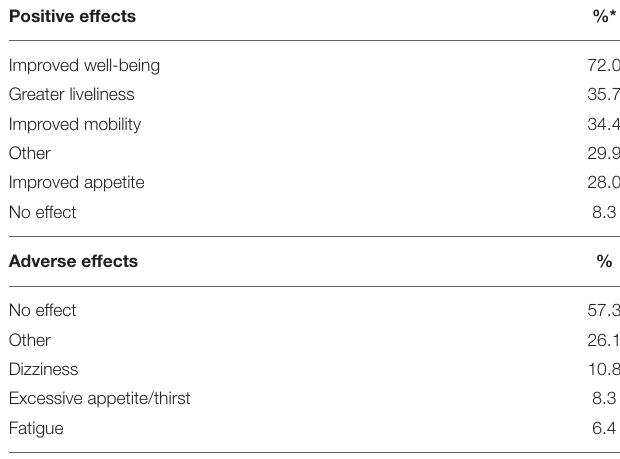
TABLE 2 | The percentage of positive and adverse effects of